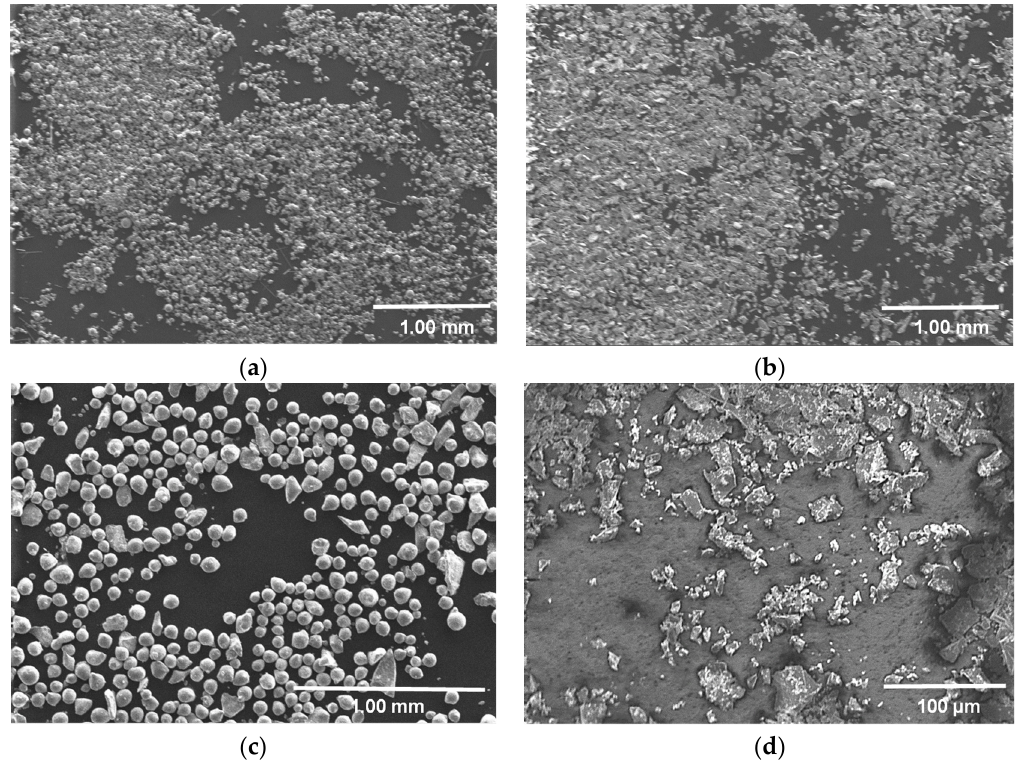
Figure 1. Field emission scanning electron microscopes micrographs of ( a ) Spheroidal powder particles Al; ( b ) Angular powder particles Mg; ( c ) Spheroidal powder particles Si; ( d ) Angular powder particles TiH 2 (TU Ilmenau; FG MWV).